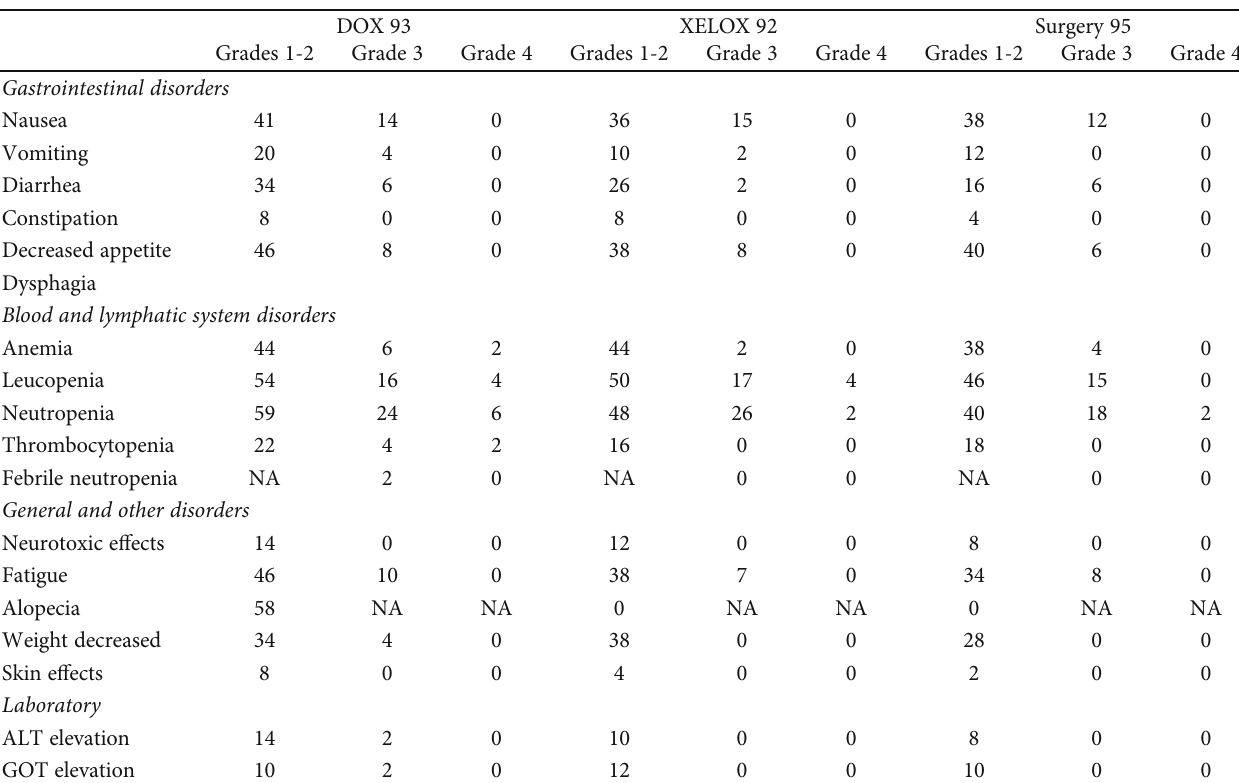
Table 3: Adverse events in 3